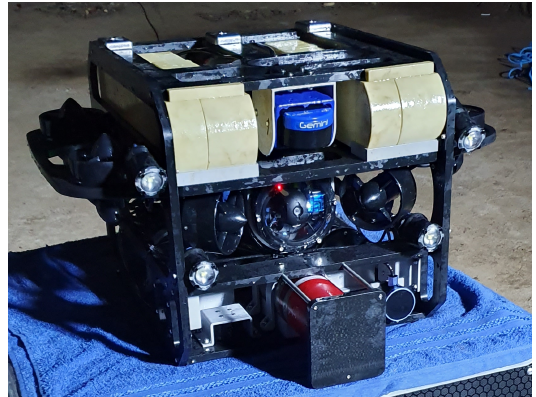
Figure 9. Robot connected to one mechanical profiling sonar (MPS) with the sensor rotation axis aligned to the robot heading.